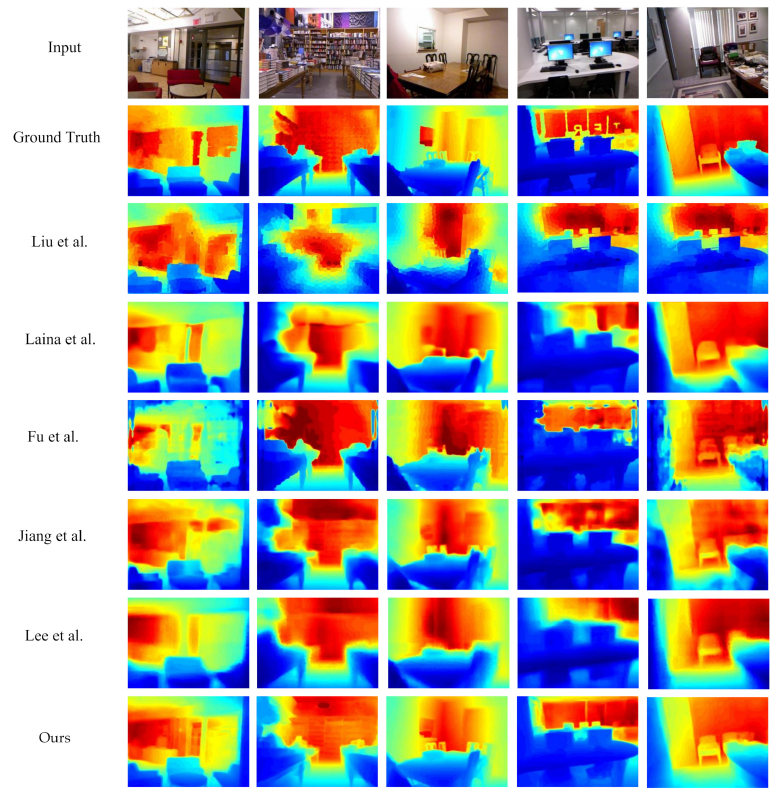
Figure 6. Assessment results for NYUv2 dataset from a qualitative perspective. First row: input, second row: ground truth, third row to last row: depths recovered by Liu et al. [21], Laina et al. [5], Fu et al. [22], Jiang et al. [48], Lee et al. [50] and our